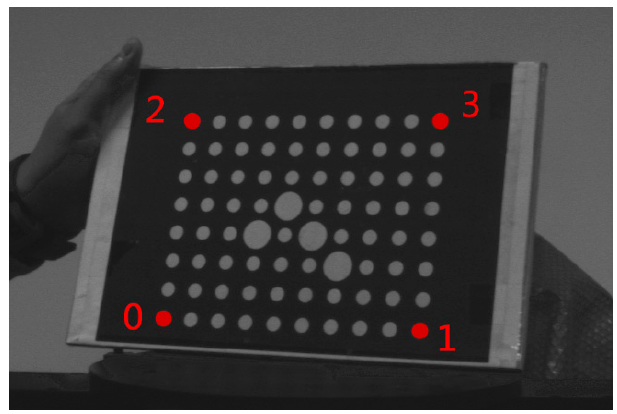
Figure 8. The image of P 0 , P 1 , P 2 , and P 3 on the calibration board.